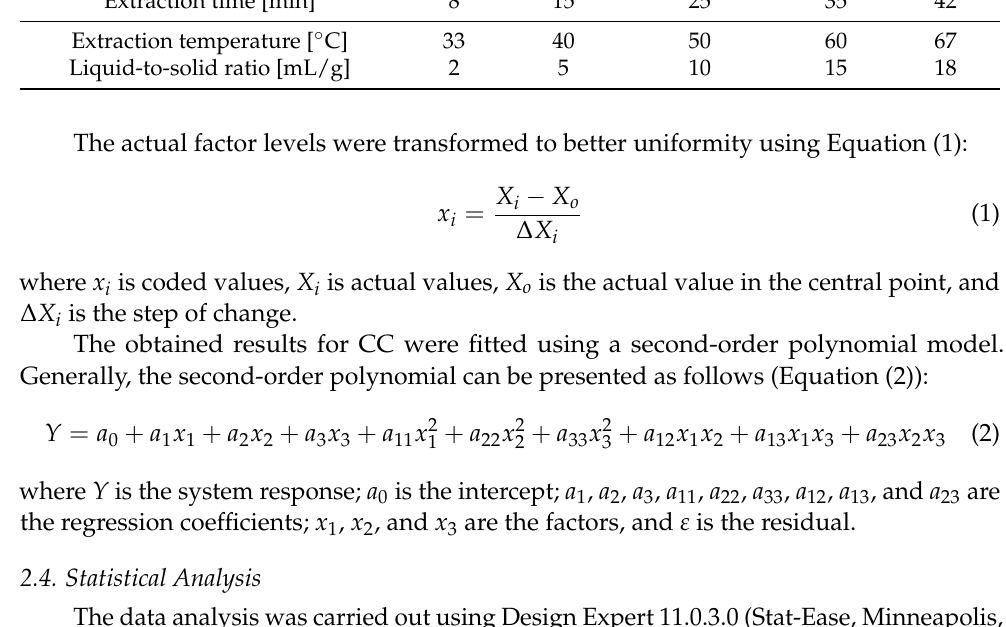
Table 1. The actual and coded factor levels of the used design.